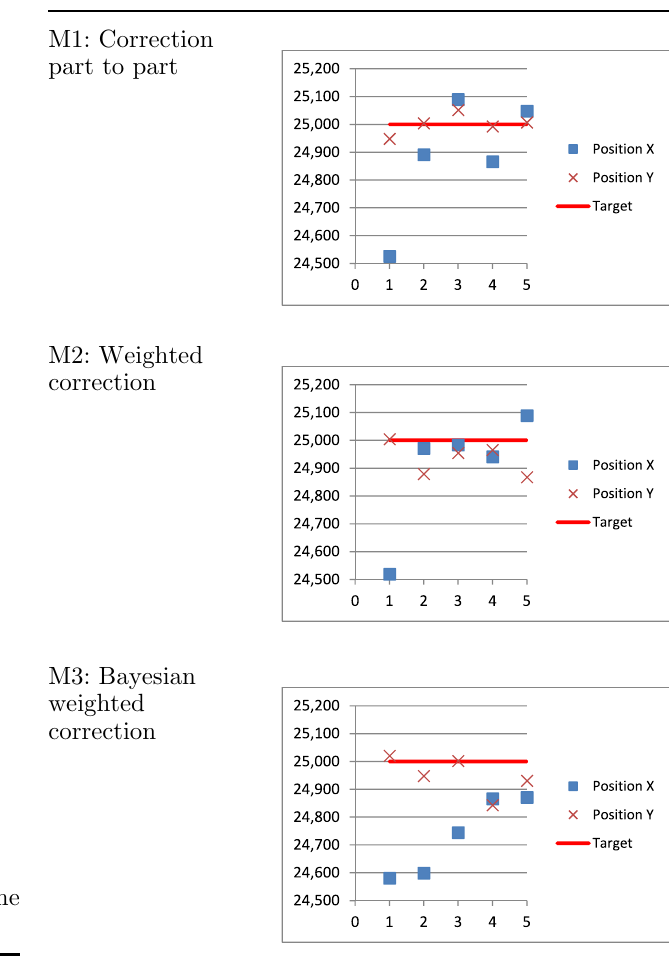
Table 6 Control of the position ( X ; Y ) of the circular